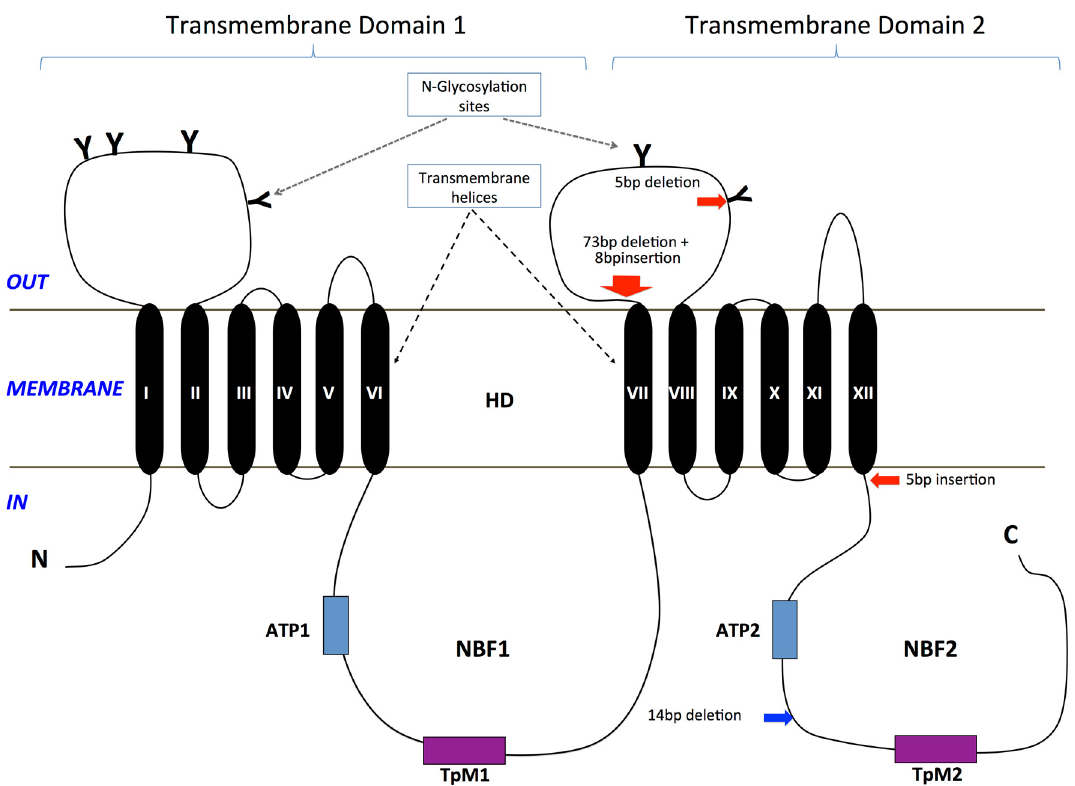
Fig 5. Diagram of the ABCA2 protein structure and location of mutations in H . armigera and H . punctigera . Glycosylation sites on the two large extracellular loops are represented by ‘ Y ’ . Two highly conserved ATP Nucleotide Binding Folds (NBF1, NBF2) that included the Transporter signature motifs 1 and 2 (TpM1, TpM2) are present in the intracellular environment. The Helicoverpa ABCA2 protein structure consists of two transmembrane domains (TMD 1, TMD 2), each with six transmembrane helices (TM I-VI in TMD 1; TM VII-XII in TMD 2). The approximate positions of the mutations in H . armigera and H . punctigera are indicated by red and blue arrows,